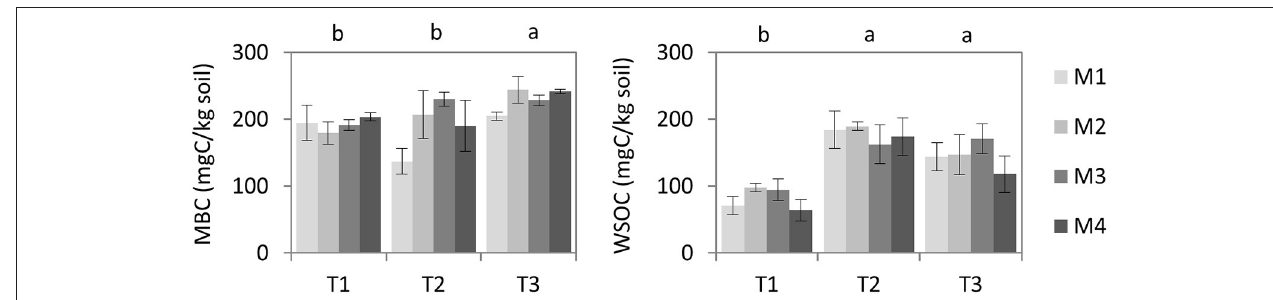
FIGURE 4 | Average values and standard errors of soil microbial biomass carbon (MBC) and water-soluble organic carbon (WSOC). These parameters were measured in the four biodisinfestation treatments (M1, M2, M3, M4) at three different times: T1 (pre-treatment), T2 (post-treatment) and T3 (post-crop after treatment). Letters indicate the significant differences among times according to Tukey HSD test ( P ≤